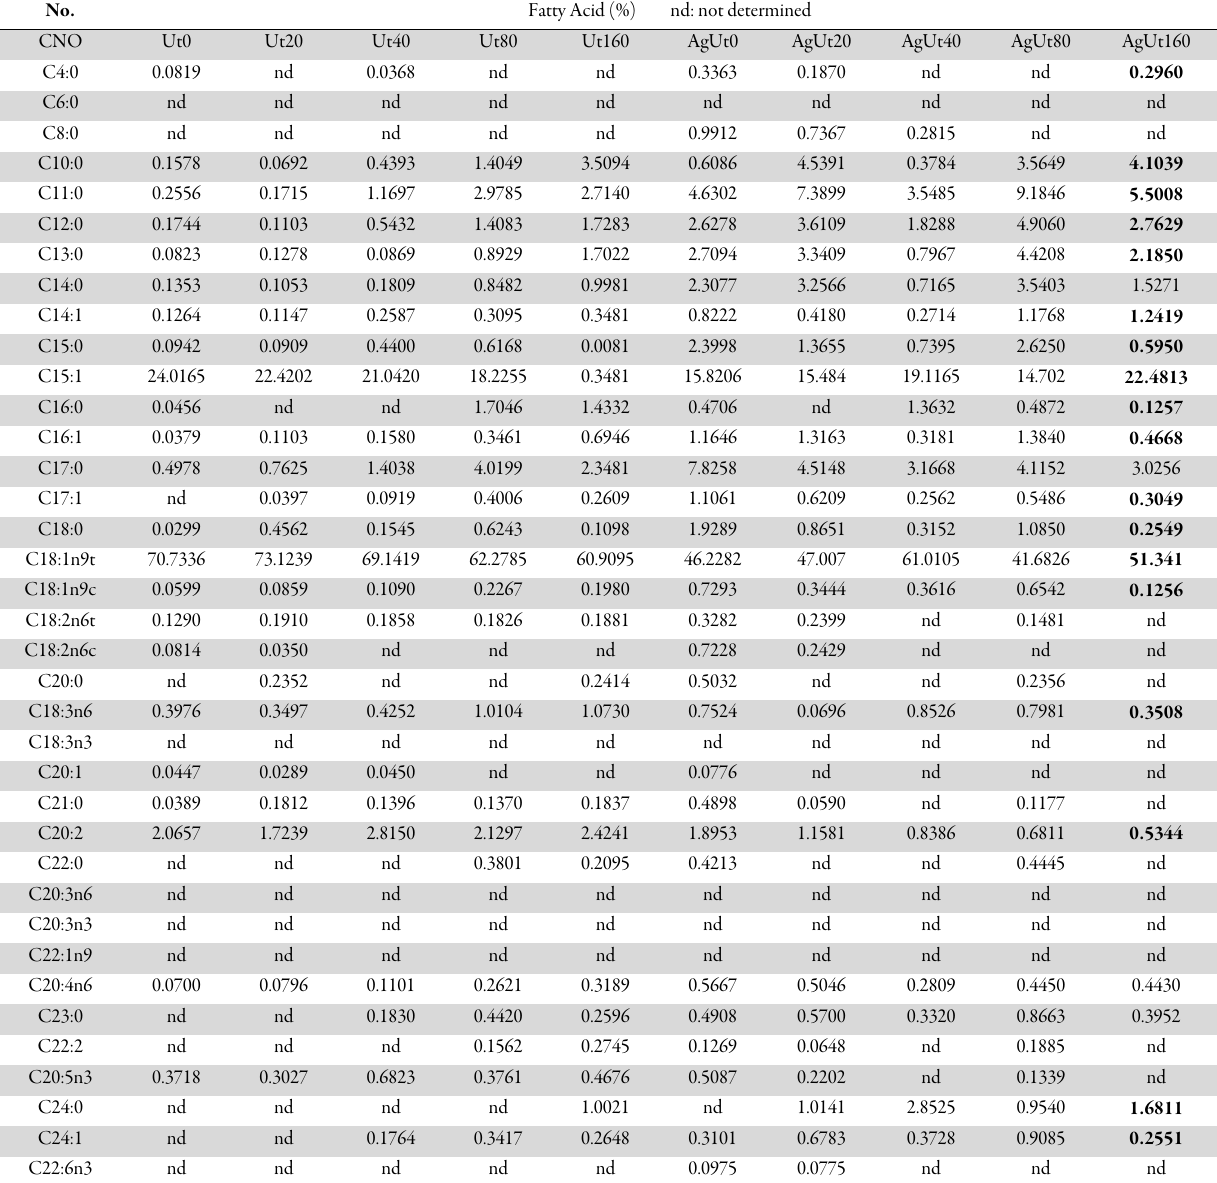
Table 2. Effect of ultrasonic assisted seed priming durations on the fatty acid compositions of aged (96 hour) and no aged Silybum marianum seeds